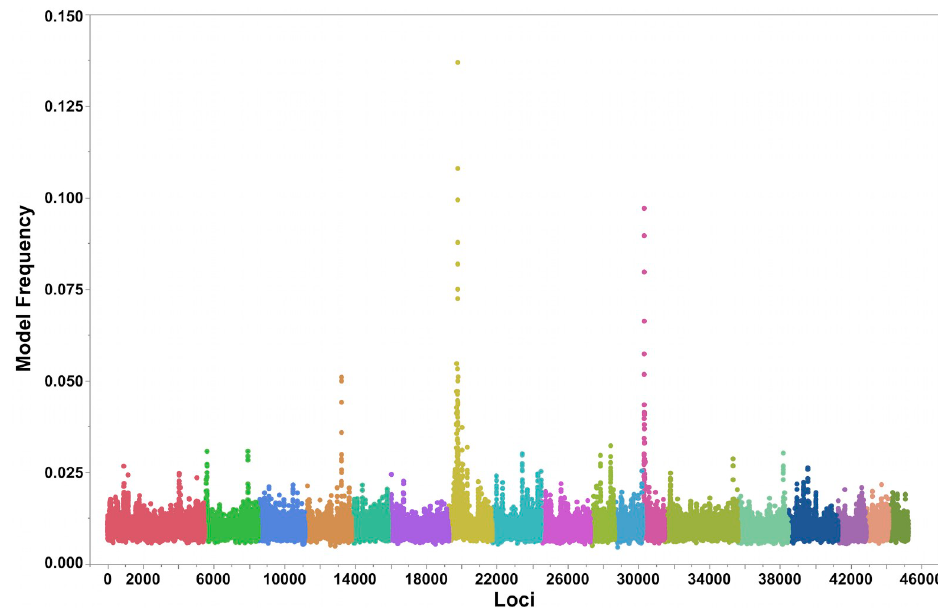
Fig 2. Genome-wide association between 51,592 SNPs and PCV2b viral load using BayesIM. Each dot represents the model frequency associated with each 50kb QTL. The X-axis represents the position of the 50 kb loci across the swine genome using Sscrofa 11.1 assembly. The Y-axis represents the model frequency of the association between a QTL and PCV2b viral load. Alternate colors represent autosomes, from SSC1 to